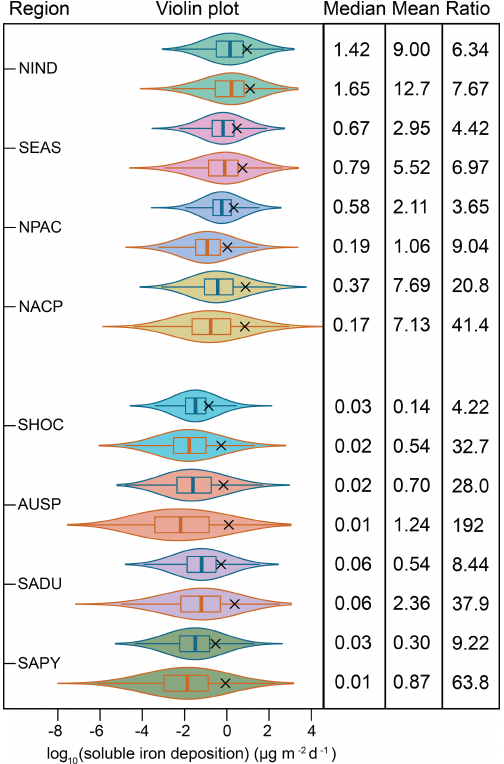
Figure 15. Violin plots of 5 years of log 10 daily soluble iron deposi- tion (µgm − 2 d − 1 ) within each grid cell for the eight ocean regions defined in Fig. 14. Only grid cells in which ocean fraction > 0 . 5 are included in the analysis. Violin colour matches Fig. 1 region colour: north Indian Ocean (NIND); South East Asian ocean (SEAS); North Pacific (NPAC); North Atlantic and central Pacific (NACP); South- ern Hemisphere oceans (SHOC); Australian and southern Pacific (AUSP); South American dust (SADU); South American pyrogenic (SAPY). Violin outline colours: blue lines: BAM results, orange lines: MAM results. Black cross: log 10 mean daily soluble iron de- position. Median, mean, and ratio (mean / median) values for all 5 years of daily deposition amounts across each basin are also